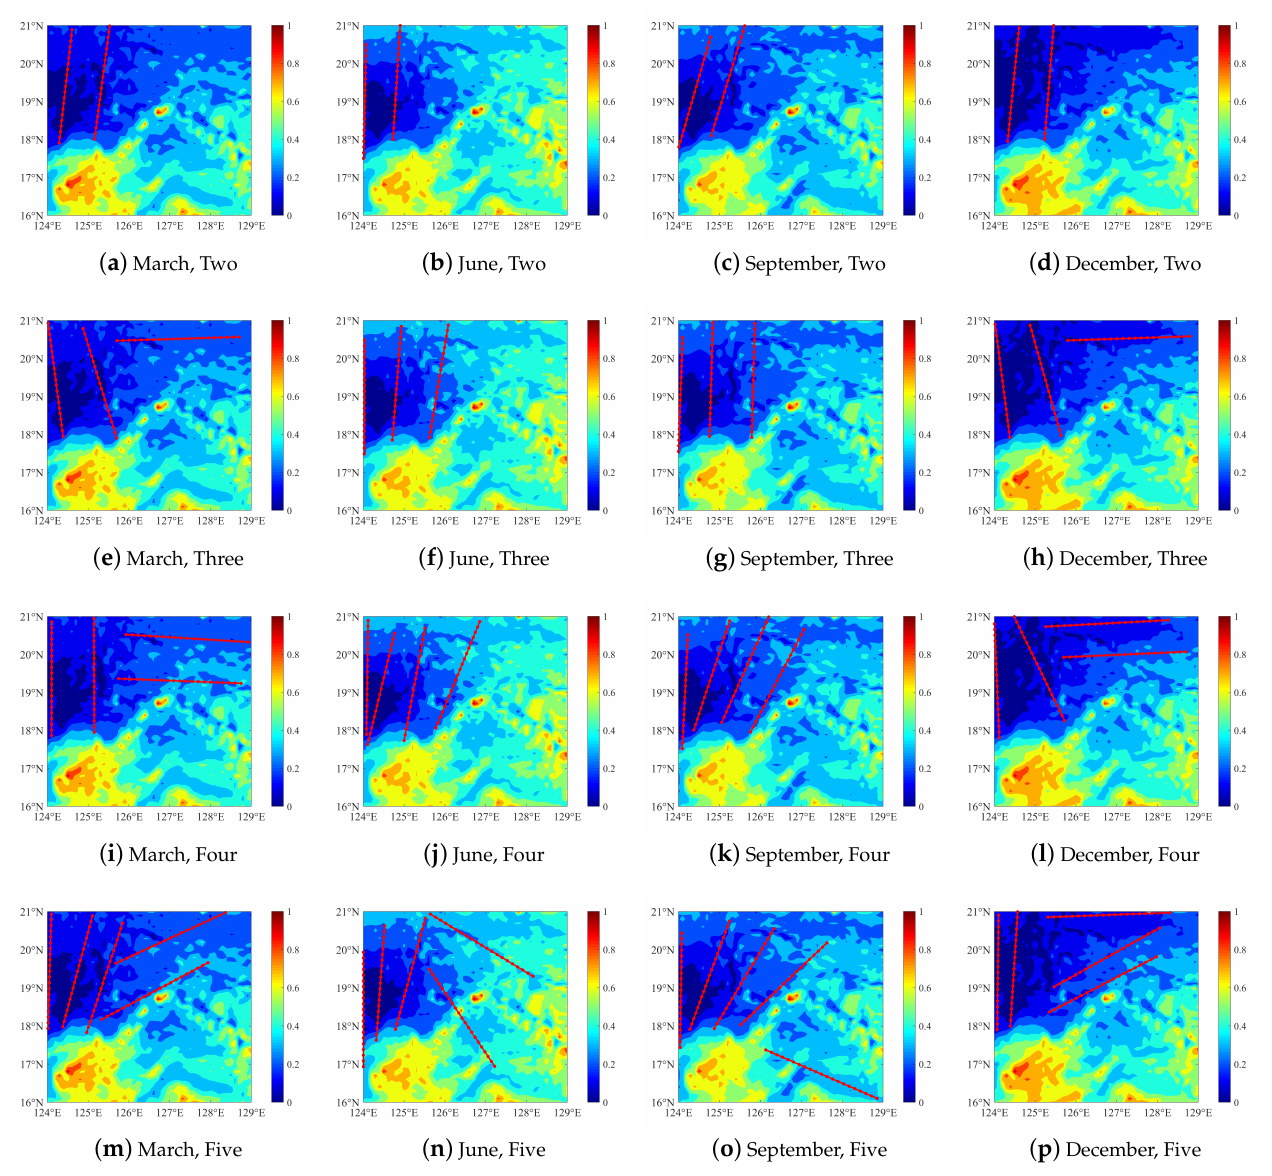
Figure 14. Optimal sampling scheme based on 2, 3, 4, and 5 platforms in the high degree of freedom.